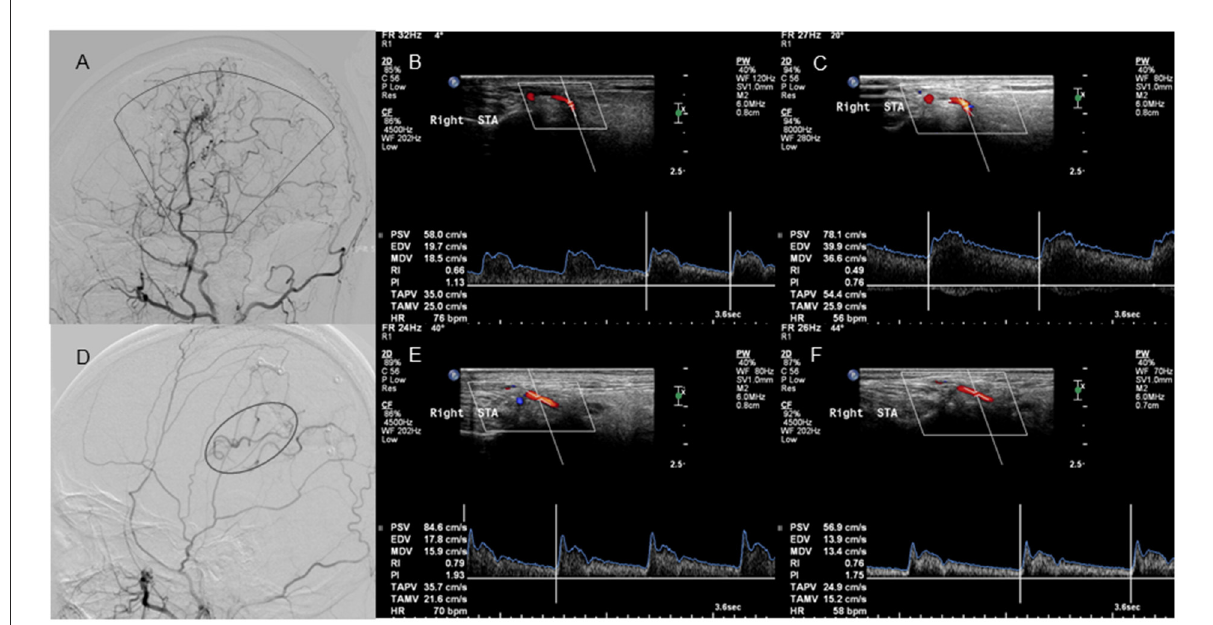
FIGURE6 Lateral projection of ECA angiogram and STA ultrasound images in patients with good and poor collateral development after EDAS. No. 1 A 25-year-old case with moyamoya disease who presented with motor weakness on the right side. (A) The lateral projection of the ECA angiogram shows that the perfusion range (sector) of STA collateral vessels exceeds 2/3 of the MCA blood supply area after EDAS in patients with good collateral development. (B) CDU shows the high RI in the STA before EDAS. (C) CDU shows the low RI with increased EDV in the STA after EDAS in patients with good collateral development. No. 2A 22-year-old case with moyamoya disease who had a language disability. (D) The lateral projection of the ECA angiogram shows that the perfusion range (oval) of STA collateral vessels is < 2/3 of the MCA blood supply area after EDAS in patients with poor collateral development. (E) CDU shows that the STA has a high RI before EDAS. (F) CDU shows that the STA still has the high RI with low EDV after EDAS in patients with good collateral development. ECA, external carotid artery; STA, superficial temporal artery; EDAS, encephalo-duro-arterio-synangiosis; MCA, middle cerebral artery; CDU, color Doppler sonography; RI, resistance index; EDV, end-diastolic